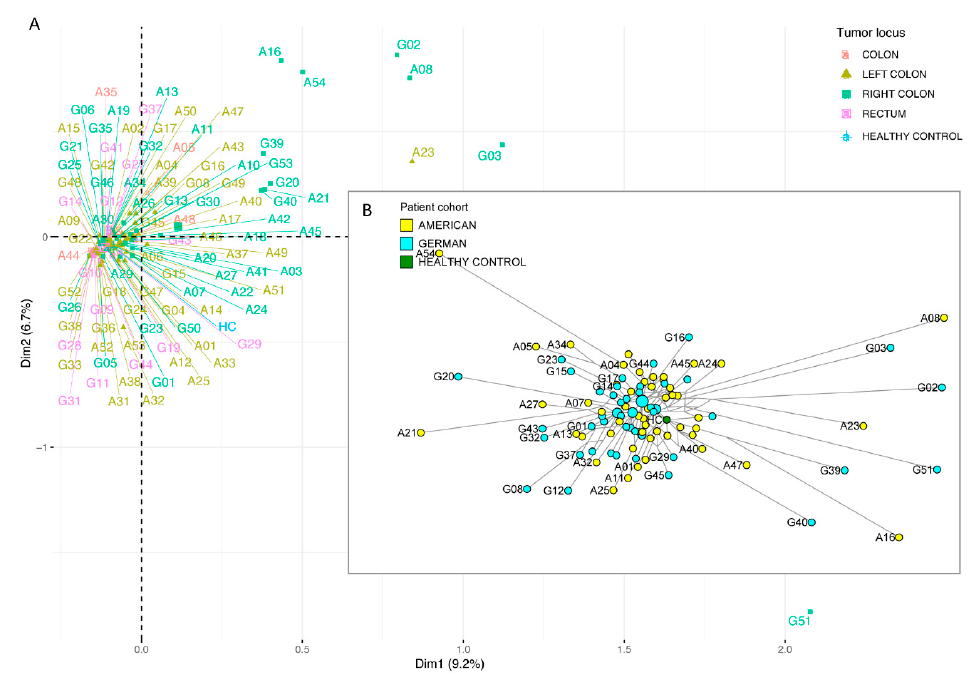
Figure 4. Mutational landscape analysis of metastatic colorectal cancer patients, based on mutated genes. ( A ) Principal component analysis and ( B ) phylogenetic network analysis independently show that microsatellite stable cancers group together while the highly mutated microsatellite instable cancers are distinct outliers, with individually mutated genes. Importantly, there is no mutational separation into American vs. German patient groups.